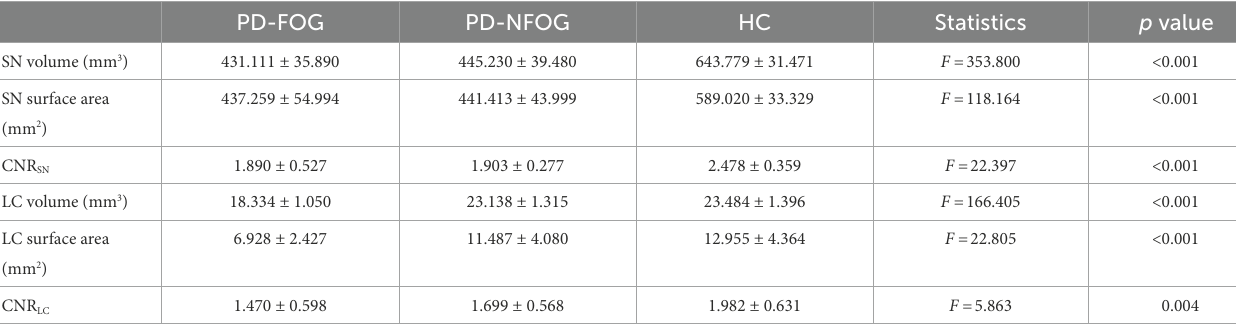
TABLE 2 Measures of SN and LC in PD-FOG, PD-NFOG and HC groups.